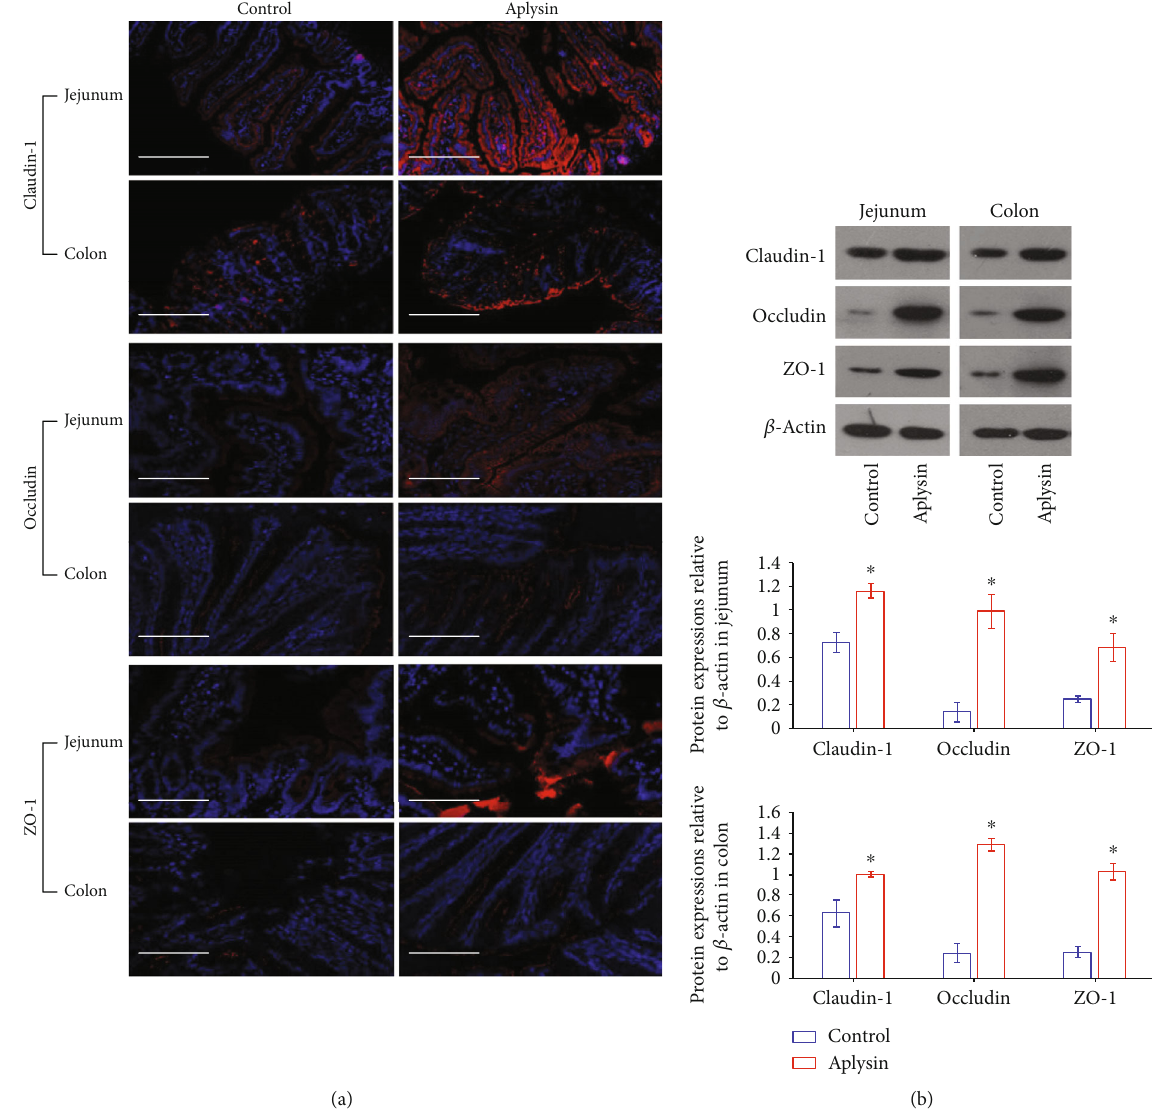
Figure 6: Expressions of tight junction-related proteins in tissues of the jejunum and colon. (a) Expressions of claudin-1, occludin, and ZO-1 protein examined by immuno fl uorescence assay. Nuclei were stained with DAPI. Scale bar = 50 μ m . (b) Expressions of claudin-1, occludin, and ZO-1 protein examined by Western blot. β -Actin was used as a loading control. ∗ p < 0 : 05 vs. the